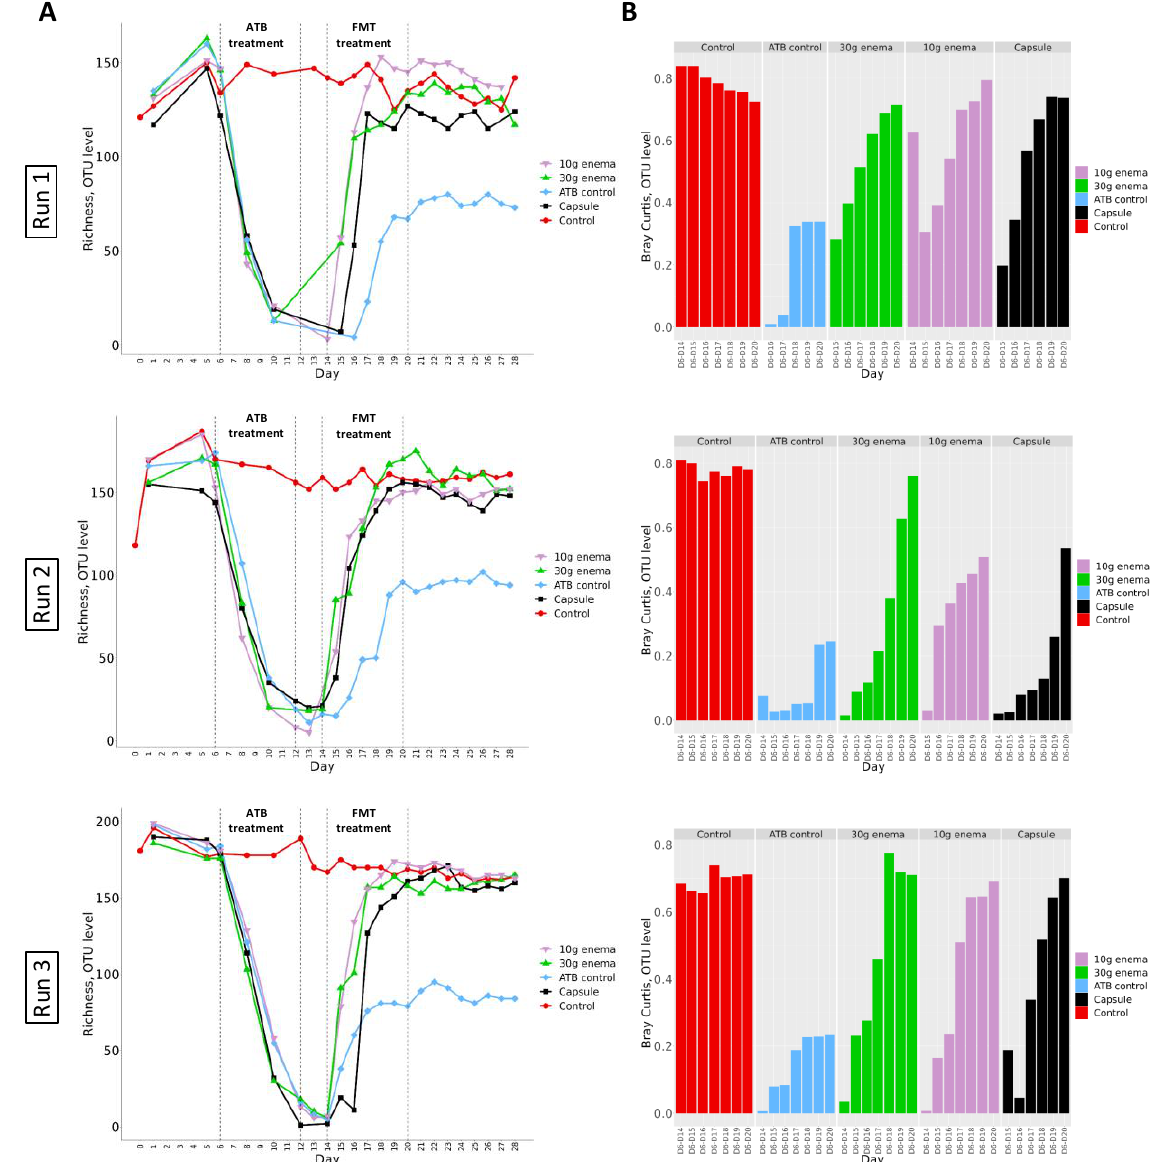
Figure 5. Effect of fecal microbiota transplantation (FMT) treatment on richness and Bray-Curtis indexes at OTU level. Experiments were performed as described in Figure 1 in triplicate with fecal samples from three healthy adult donors (Run1, Run2 and Run3). Different conditions were ap- plied: no treatment (control, red), ciprofloxacin (ATB control, blue), ciprofloxacin and 30 g enema (green), ciprofloxacin and 10 g enema (purple), and ciprofloxacin with oral cap- sules (black). Richness (panel A) and Bray-Curtis (panel B, compared to day 6 values) in- dexes were determined at the OTU level after 16S-rRNA gene sequencing. Bray-Curtis values represent similarity of samples versus day 6. 3.6.2. β- Diversity Bray-Curtis dissimilarity was calculated as an indicator of β-diversity compared to values obtained at day 6 (end of stabilization phase for each bioreactor). Results obtained